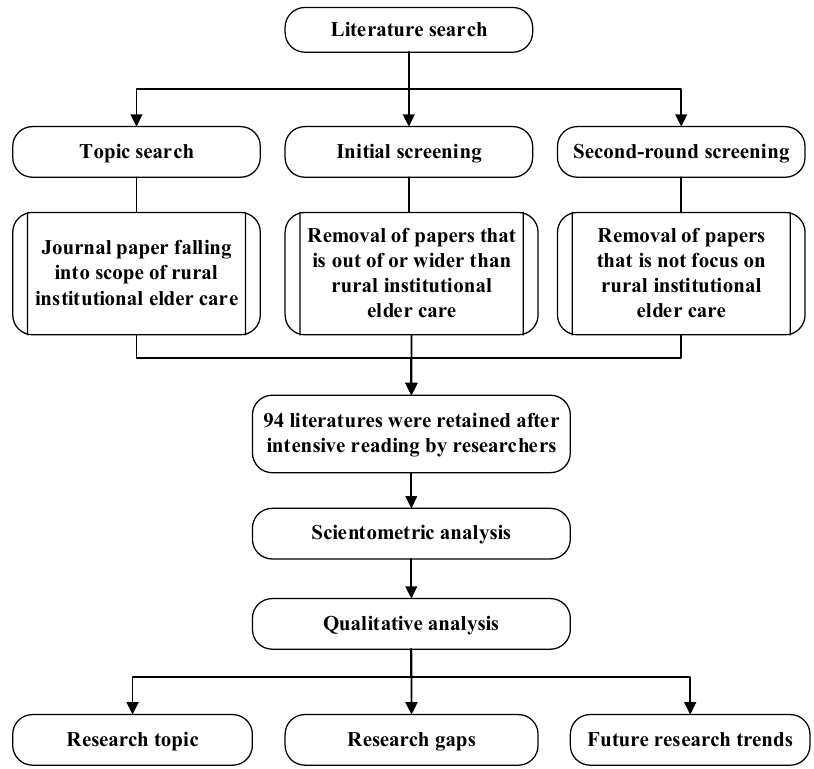
Figure 1. Flow chart of scoping analysis of literature on rural institutional elder care.